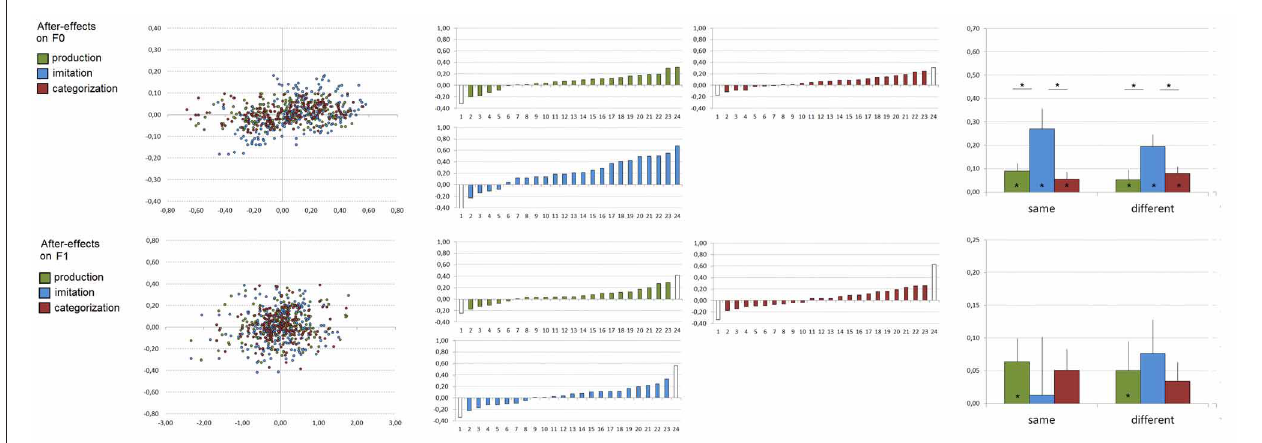
FIGURE 3 | After-effects observed after vowel production (in green), imitation (in blue) and manual categorization (in red) on F 0 (top) and F 1 (bottom) values. Left: All correlation-points based on 4320 utterances related to participants’ imitative changes during the presentation of acoustic targets compared to their baseline productions ( X -axis: acoustic target minus subject’s production during the first presentation of visual targets, Y -axis: subjects’ production during the second presentation of visual targets minus subject’s production during